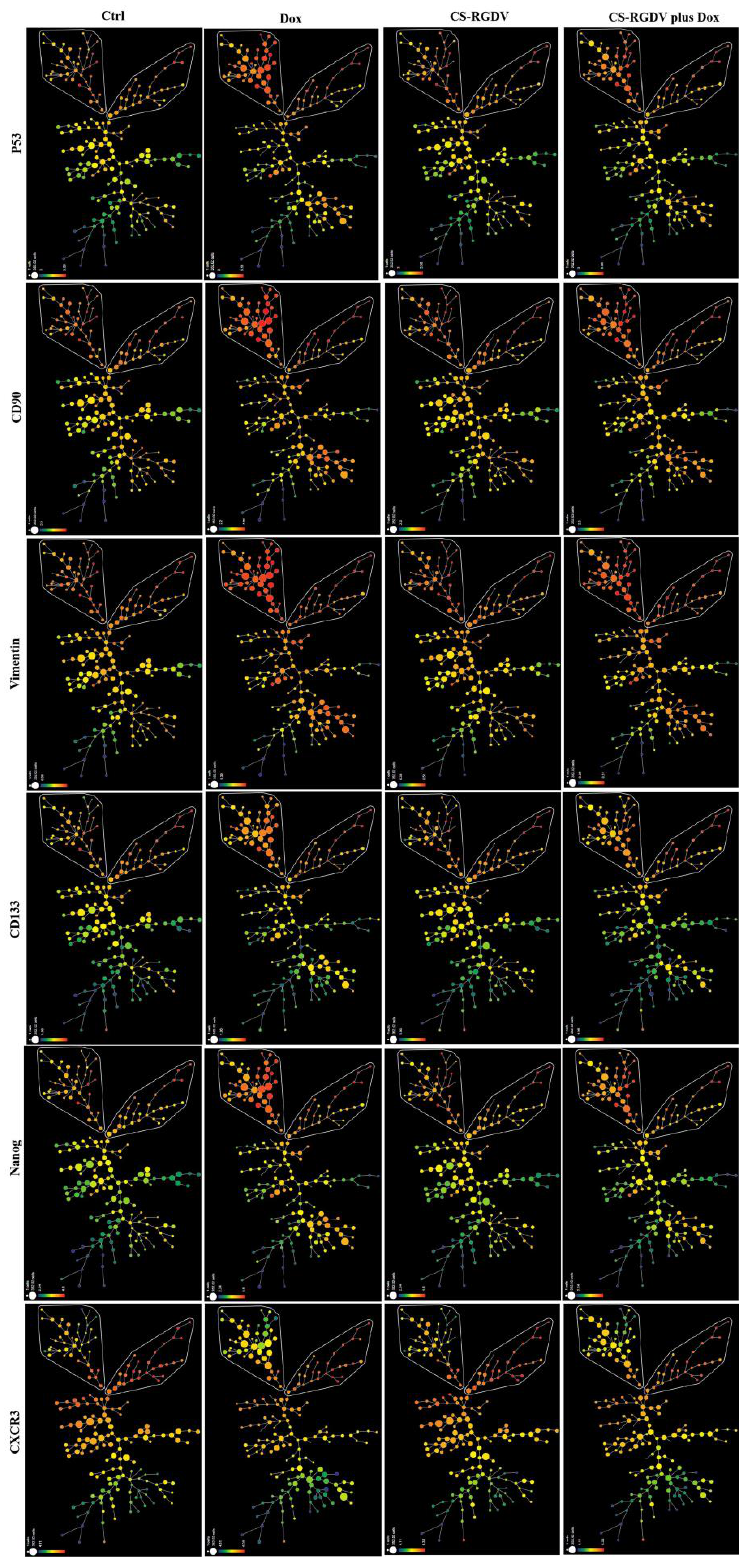
Figure 4. SPADE analysis (green-to-red scale, red represented high expression) showed stemness induced by doxorubicin was decreased in combination with CS-V nanoparticles. All the nodes in the figures represent a group of cells with similar protein expression patterns, and the size of the node represents the frequency of this group of